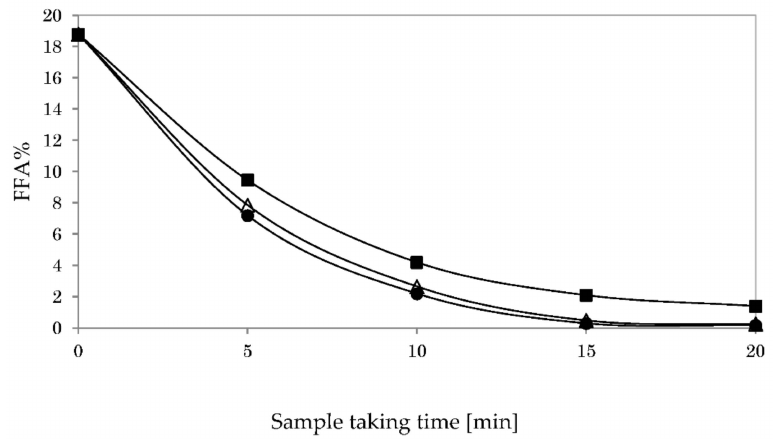
Figure 16. Impact of the type of the Co-Solvent on glycerolysis reaction ( (cid:4) : toluene, ∆ : hexane,